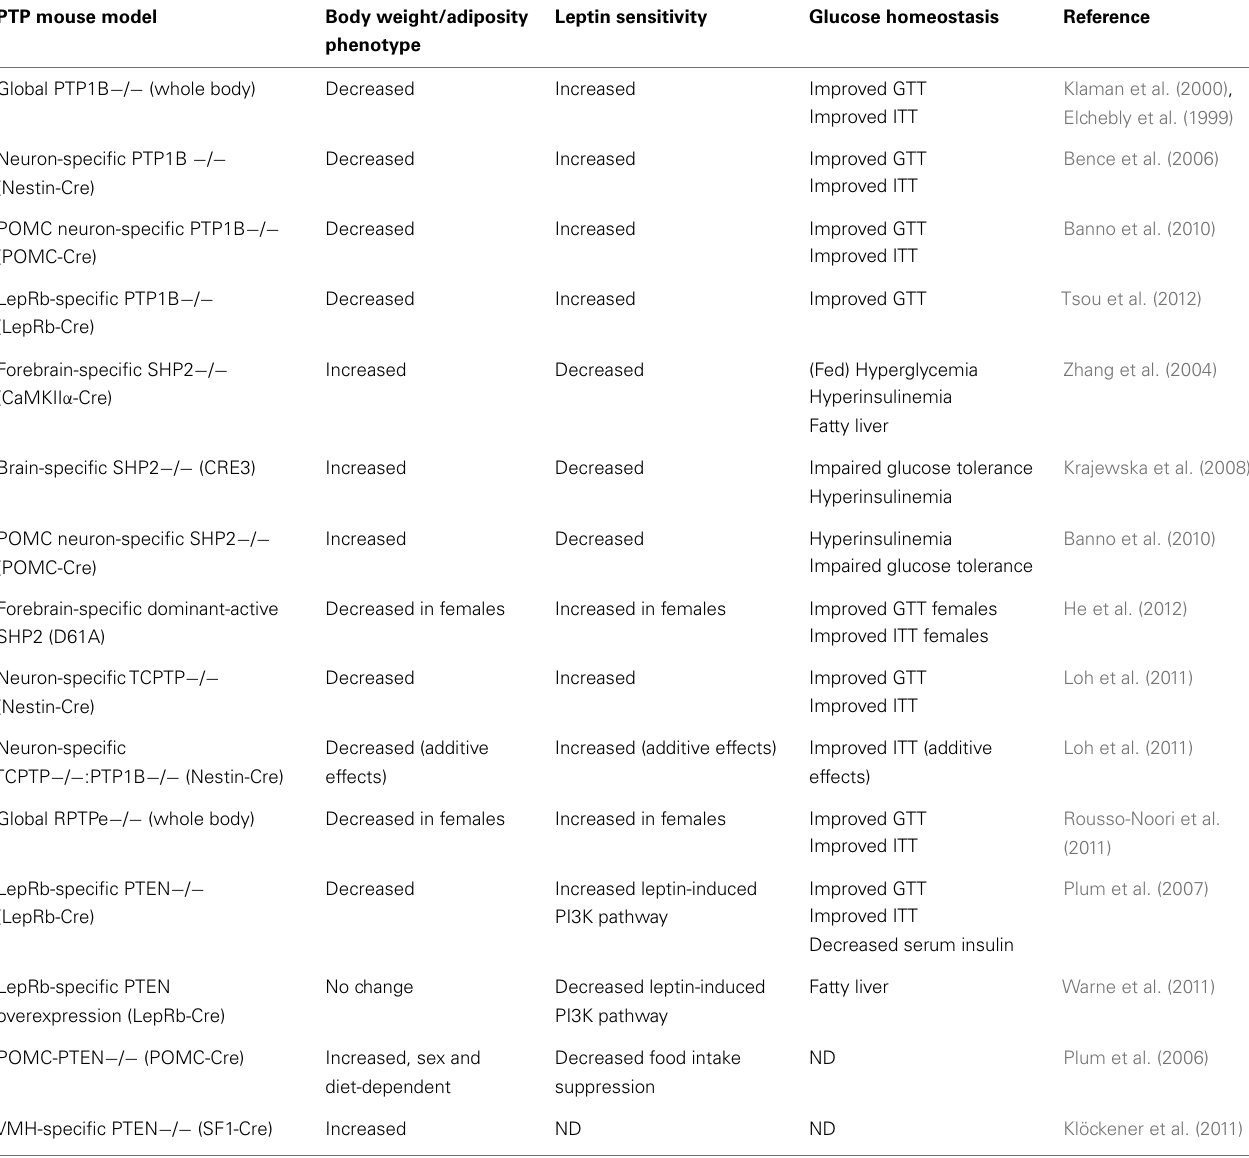
Table 2 | Summary of CNS PTP-genetic mouse models and their associated metabolic